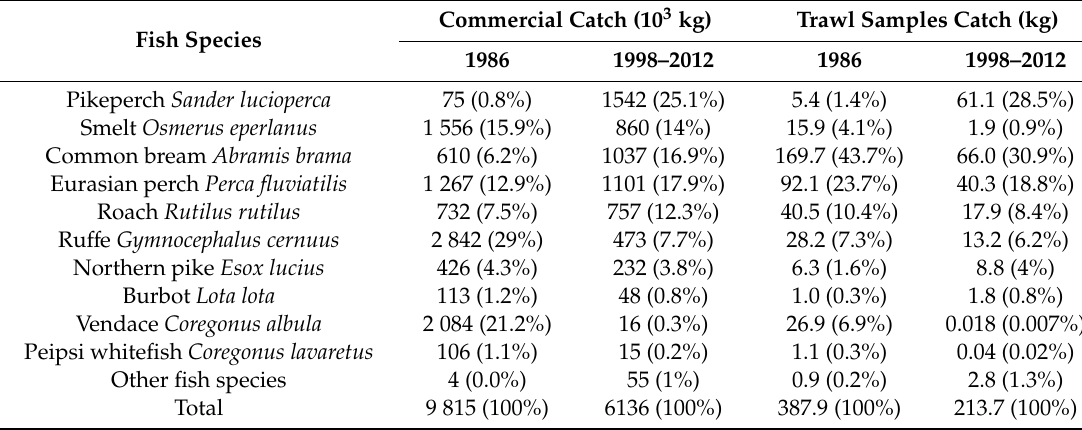
Table 2. Species composition and annual commercial catches according to fishery statistics from 1986 and 1998–2012 and average catch per unit e ff ort (CPUE; kg per trawl-hour) of trawl samples taken in autumn during the same years in Lake